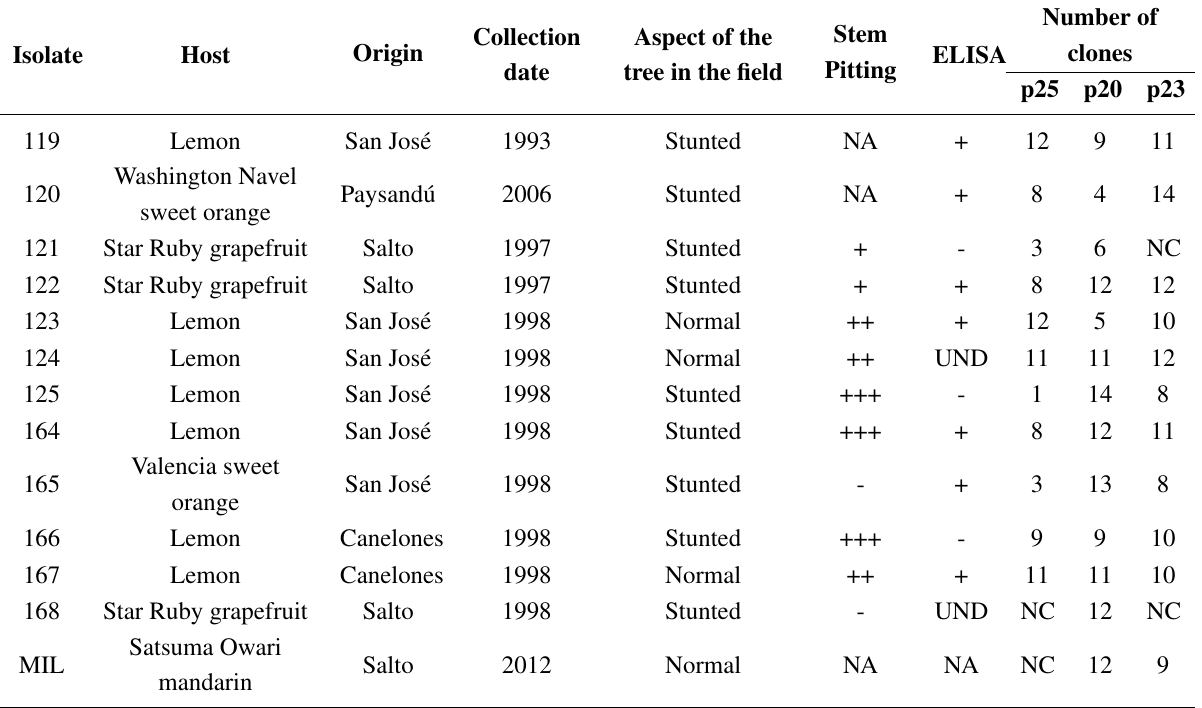
Table 2. Characteristics of the Uruguayan isolates used in the present